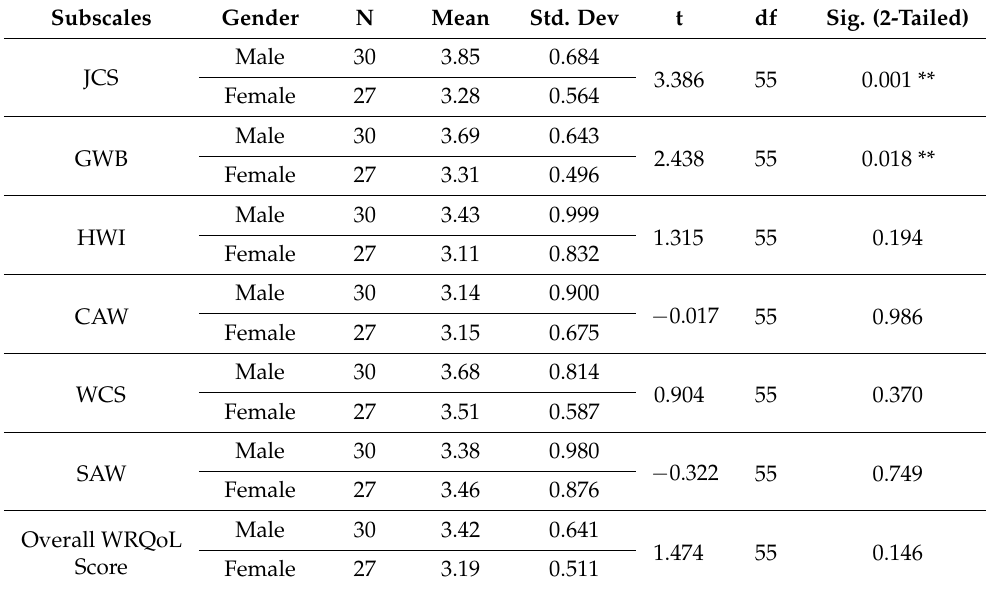
Table 5. WRQoL-2 Subscales According to Gender